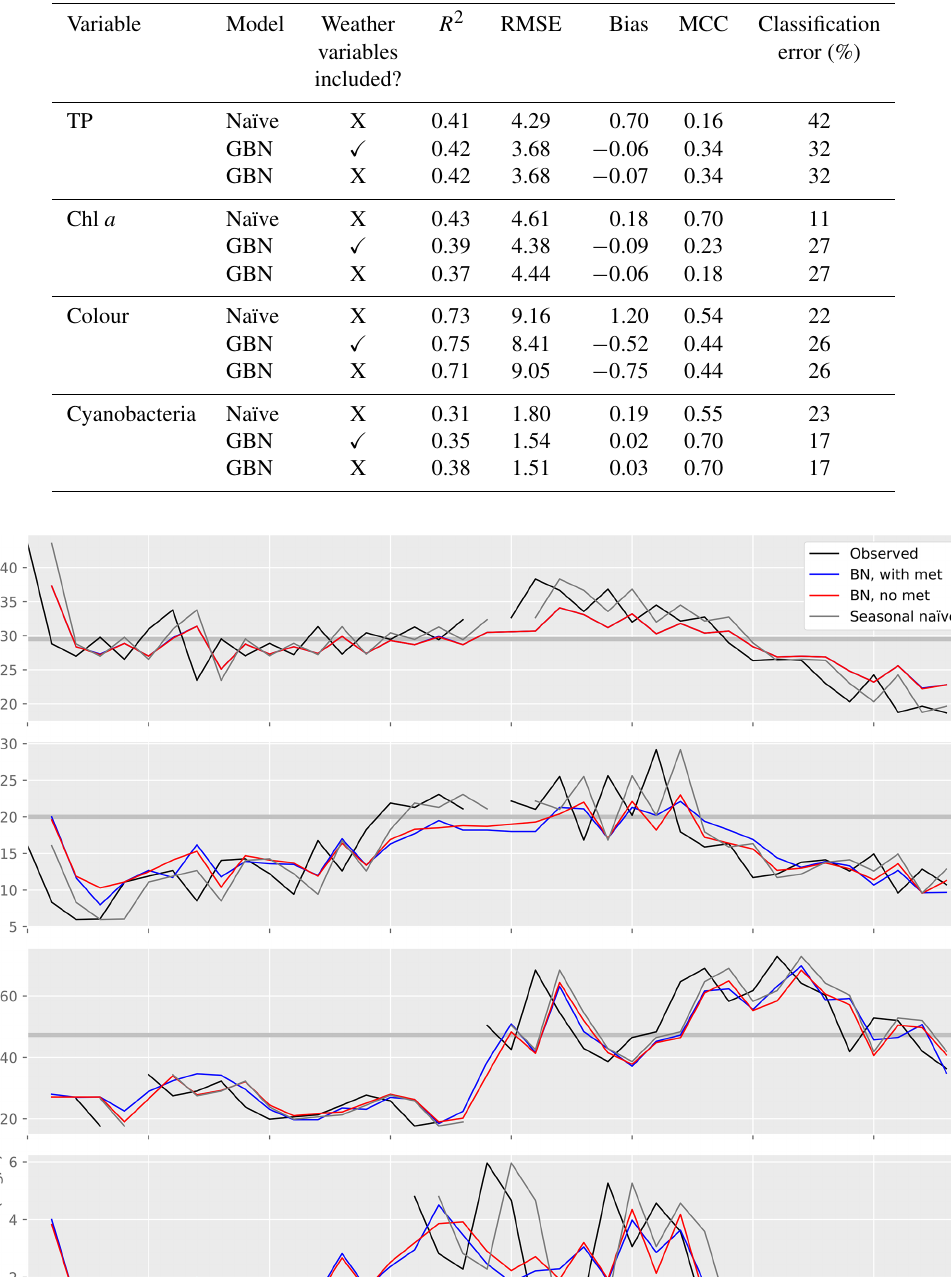
Table 6. Performance of the GBN, with and without weather nodes, fit using the whole historic period (no cross-validation) and the whole BN. Performance of the seasonal naïve forecast is also shown. The MCC and classification error reflect classifier skill, while other statistics reflect how well the mean predicted values match observations. Note: RMSE is root mean square error; MCC is Matthews correlation coefficient.